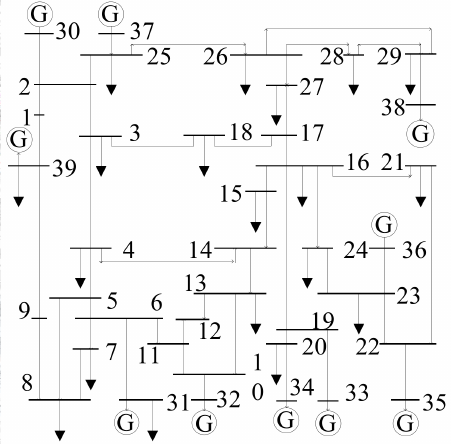
Figure 5. Diagram of the IEEE-39 bus test